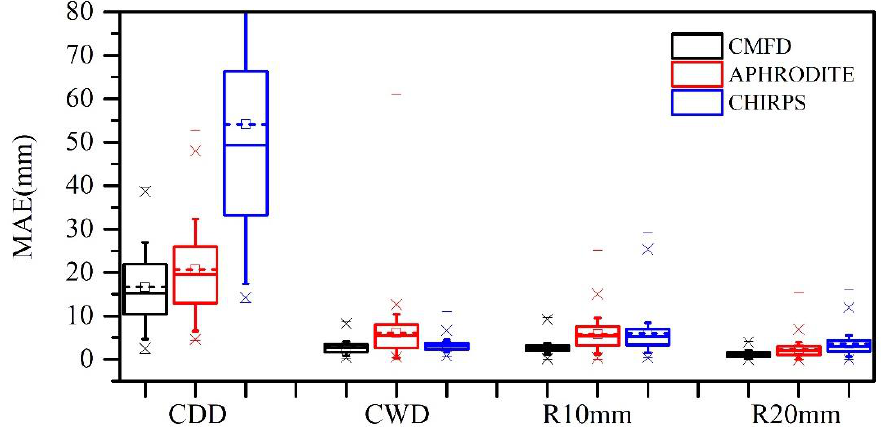
Figure 4. Boxplots of the mean absolute error (MAE) for gauge-based fixed threshold indices CDD, CWD, R10mm, and R20mm, as derived from CMFD, APHRODITE, and CHIRPS at 101 rain-gauges. Five lines from bottom to top for one box represent minimum value, 25th percentile, 50th percentile, 75th percentile, and maximum value, respectively. The quadrate inside the box represents the mean values. The asterisks represent several possible alternative values.